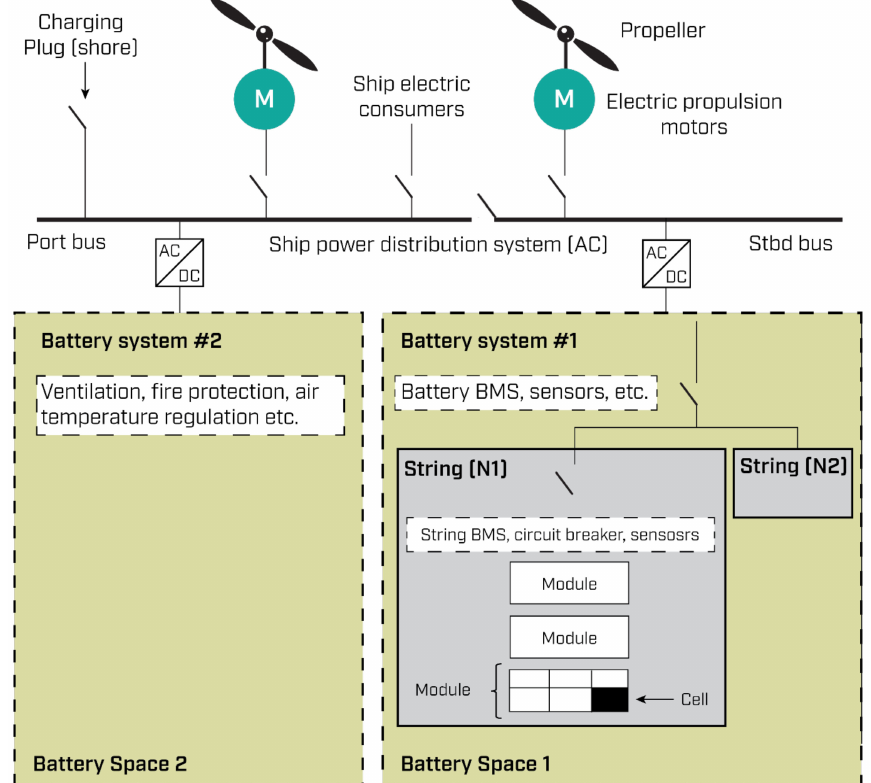
Figure 2. Generic maritime battery system (Reprinted/adapted with permission from [16]. Copyright 2022, DNV